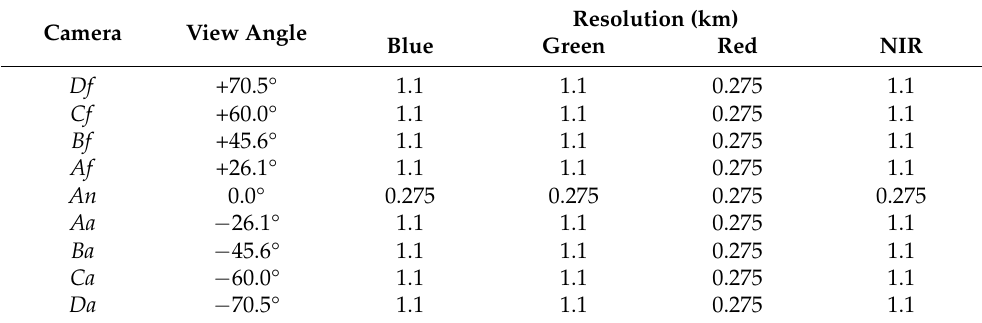
Table 1. MISR multi-angle imaging characteristics to illustrate the different view angles and resolu- tions for the nine MISR cameras and four bands, assuming primary operation in global mode.